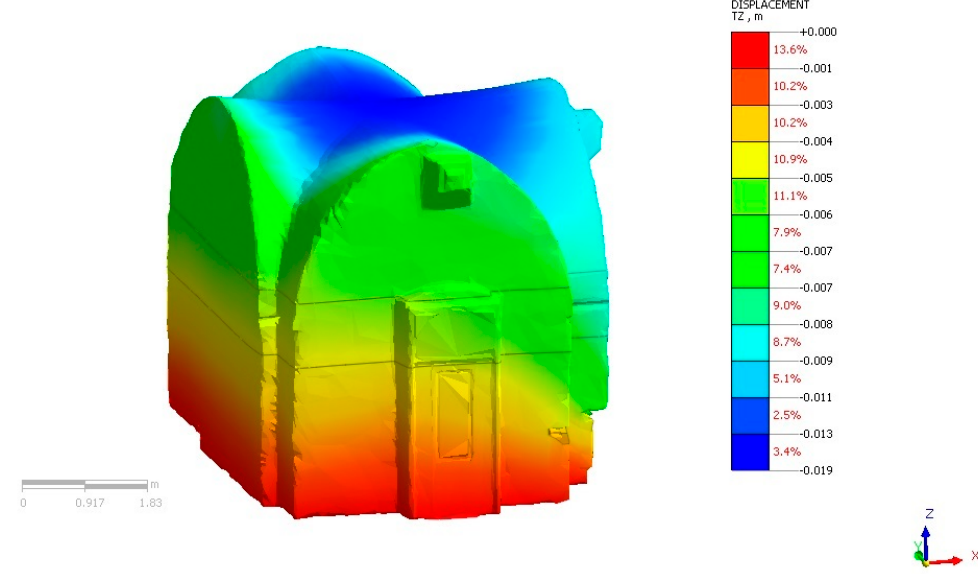
Figure 15. Static analysis: results of deformations of the structure. The maximum value achieved was 1.8 mm (blue) while the minimum was 1.2 mm (red).